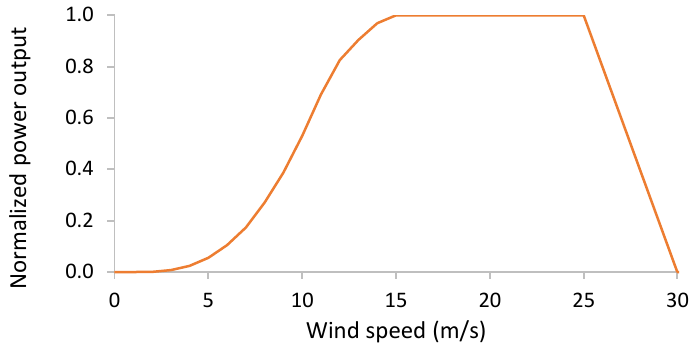
Figure 4. Ideal wind turbine power curve.